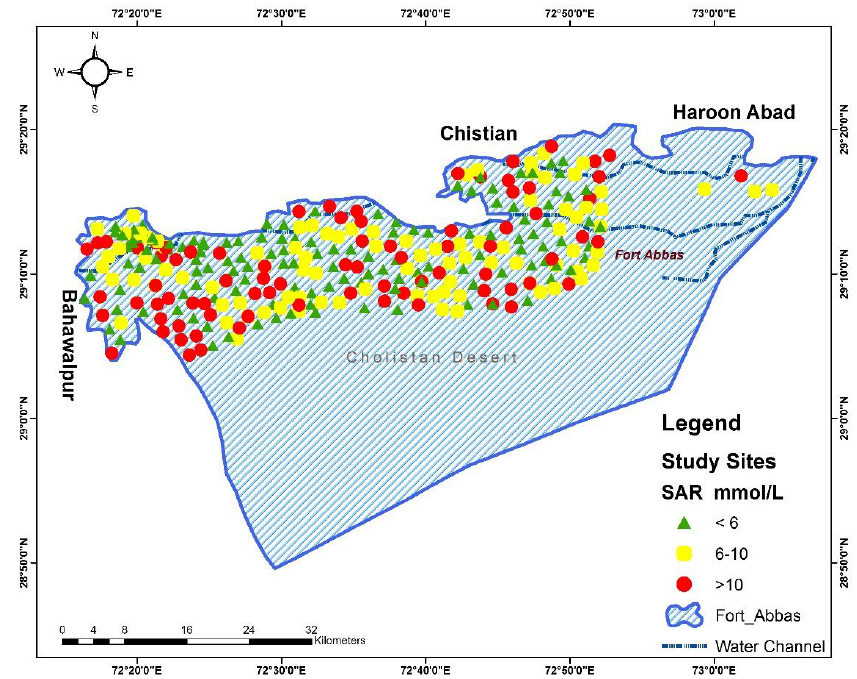
Figure 3. Status of sodium adsorption ratio (SAR) of groundwater in Tehsil Fort Abbas.